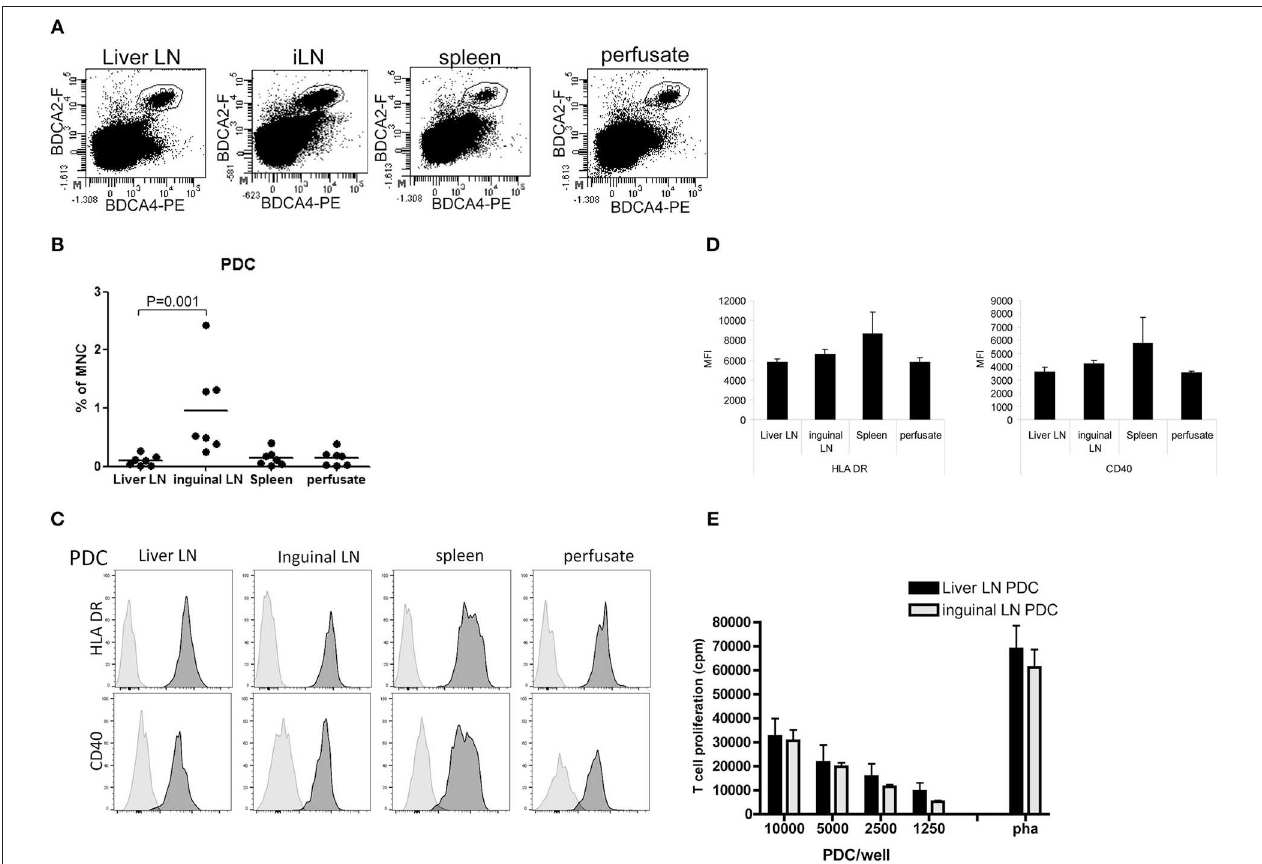
FIGURE 4 | PDC in hepatic and inguinal lymph nodes, spleen and liver. (A) Flowcytometric determination of PDC in MNC isolated from hepatic and inguinal lymph nodes, spleen, and liver perfusate using anti-BDCA2 and anti-BDCA4 antibodies. Non-hematopoietic cells and dead cells were excluded from the analysis by exclusion of CD45 − cells and 7-AAD + cells. (B) Percentages of BDCA2 + BDCA4 + PDC within MNC in the different tissues. Dots represent data from individual tissues and lines indicate mean values. (C) Histograms showing HLA-DR and CD40 expression on PDC from the different tissues. Light gray histograms are isotype control stains. (D) Summary of the expression levels of HLA-DR and CD40 on PDC in hepatic (H) lymph nodes ( n = 6) and inguinal lymph nodes ( n = 7), spleen ( n = 6), and liver ( n = 6). Data are depicted as means with SEM. No significant differences were observed (E) Graded numbers of purified hepatic ( n = 6) and inguinal LN PDC ( n = 5) were co-cultured with allogeneic T-cells (from one batch) and T-cell proliferation was assessed after 5 days by [ 3 H]-thymidine incorporation. T-cell proliferation in response to PHA is depicted as positive control condition. Data represent means with SEM. No significant differences were